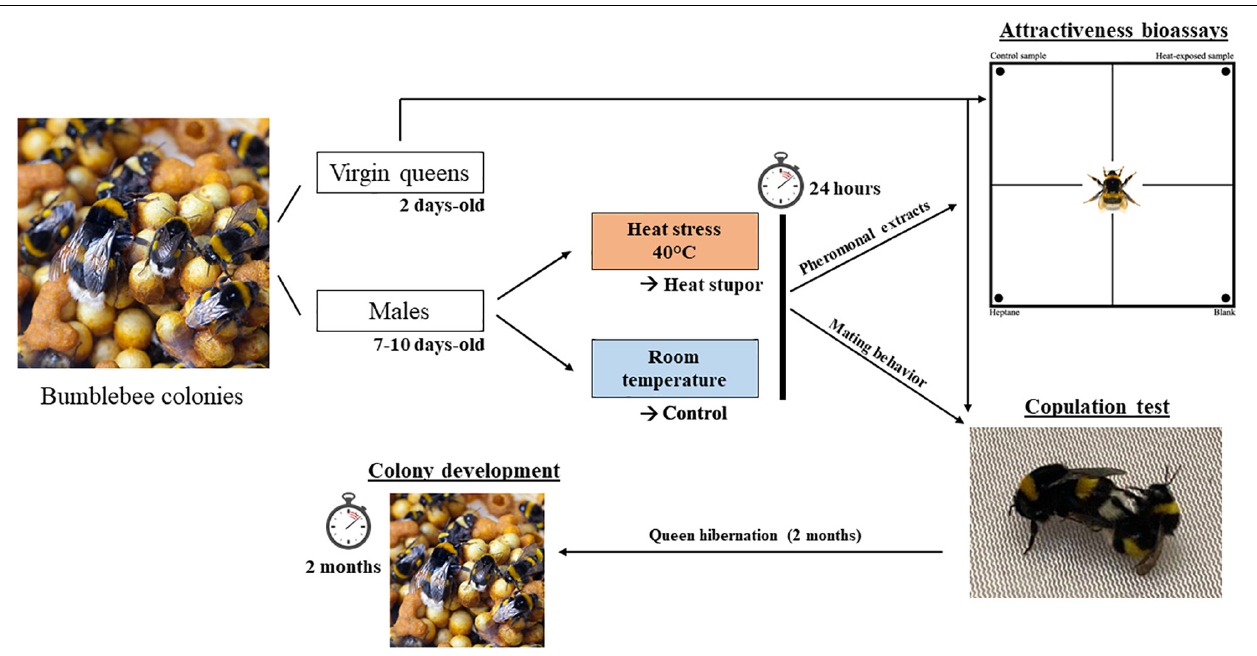
FIGURE 1 | Experimental design. Virgin queens and males were produced from queen-right colonies. Males aged of 7–10 days were split in two condition groups: heat-stressed group (40 ◦ C) and control group (25 ◦ C). Each group were allowed to rest 24 h before the experiment for standardization. For each condition we